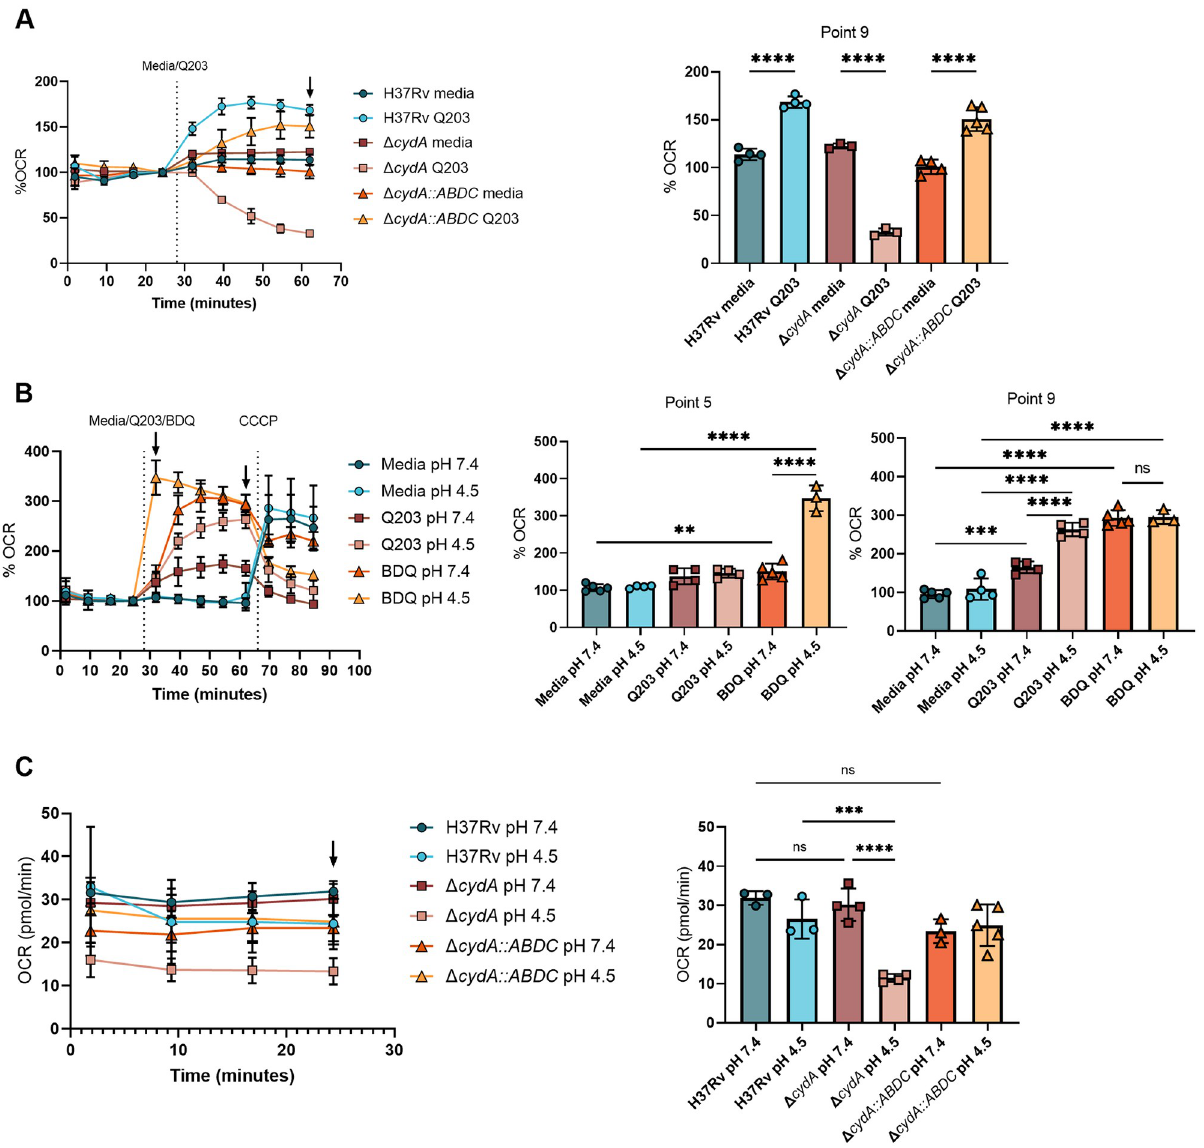
Fig 4. The bd oxidase is necessary for optimal respiration under low pH conditions. Oxygen consumption rate (OCR) was measured using the extracellular flux analyser. A) H37Rv, Δ cydA and Δ cydA :: ABDC strains were exposed to media at pH 7.4 for ~30 minutes and then treated with Q203 (10nm) at the indicated time. Data are normalized to point 4. Bar graph of point 9 (black arrow). B) H37Rv was exposed to media at pH 7.4 and pH 4.5 for ~30 minutes and then treated with media, Q203 (300x MIC 50 900nM), or BDQ (300x MIC 50 16.2uM) followed by the uncoupler, CCCP, at the indicated times. Data are normalized to point 4. Bar graphs are plotted from point 5 and point 9 (black arrows in A) after the addition of BDQ/Q203 and before the addition of CCCP, respectively. C) OCR measurements (pmol O 2 /min) of H37Rv, Δ cydA and Δ cydA :: ABDC strains after ~30 minutes pre-exposure to media at pH 7.4 or pH 4.5. Bar graphs are plotted from point 4 (black arrow). Analysis was performed using a one-way ANOVA with Tukey post-test. � p-value < 0.05, �� p-value < 0.01, ���� p-value < 0.0001. Data depict single experiments that are representative of at least 2 independent